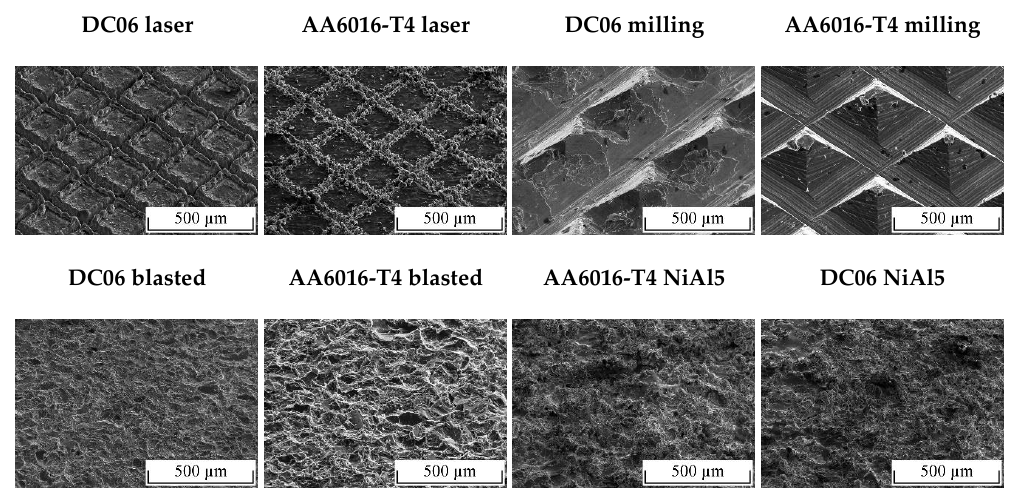
Figure 6. SEM images of the differently structured surfaces for DC06 and AA6016-T4.